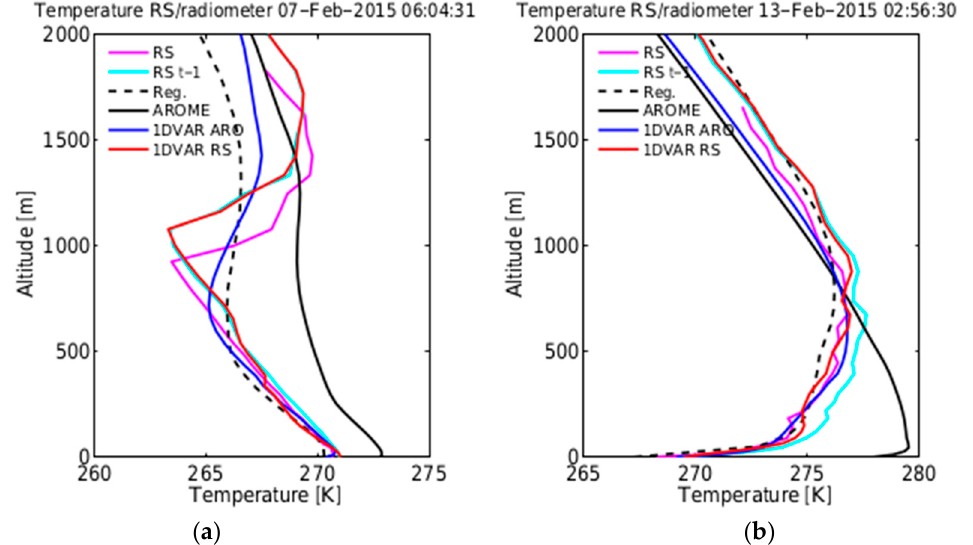
Figure 5. Vertical profiles of temperature in the Arve valley (Passy-2015 field experiment) during convective conditions on 7 February 2015 at 06:04 UTC ( a ) and during stable conditions on 13 February at 02:56 UTC ( b ). Comparison between radiosonde profiles (magenta), linear regression (dashed black line) and 1D-VAR from AROME model forecasts (blue), 1DVAR from previous radiosonde (red). Background profiles corresponding to either the 1 h AROME model forecast (black) or the previously launched radiosonde (cyan) are also shown (from [96], Copyright: Open Access, CC-BY).